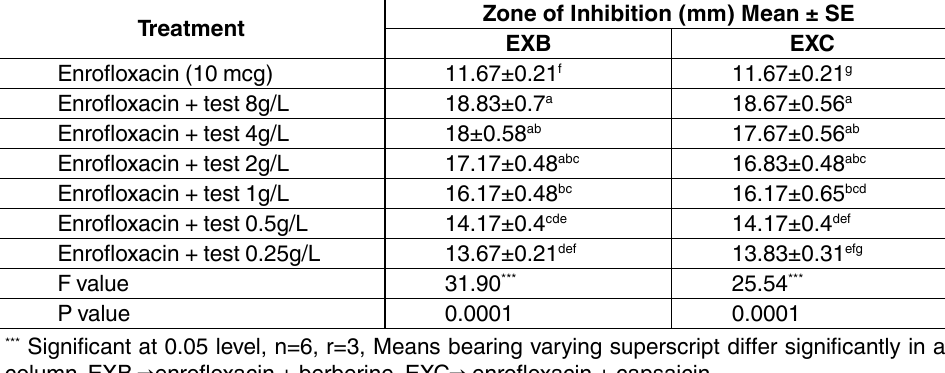
Table 1 . Zone of inhibition (mm) of quinolone resistant S. aureus against enrofloxacin with different combinations of berberine and capsaicin